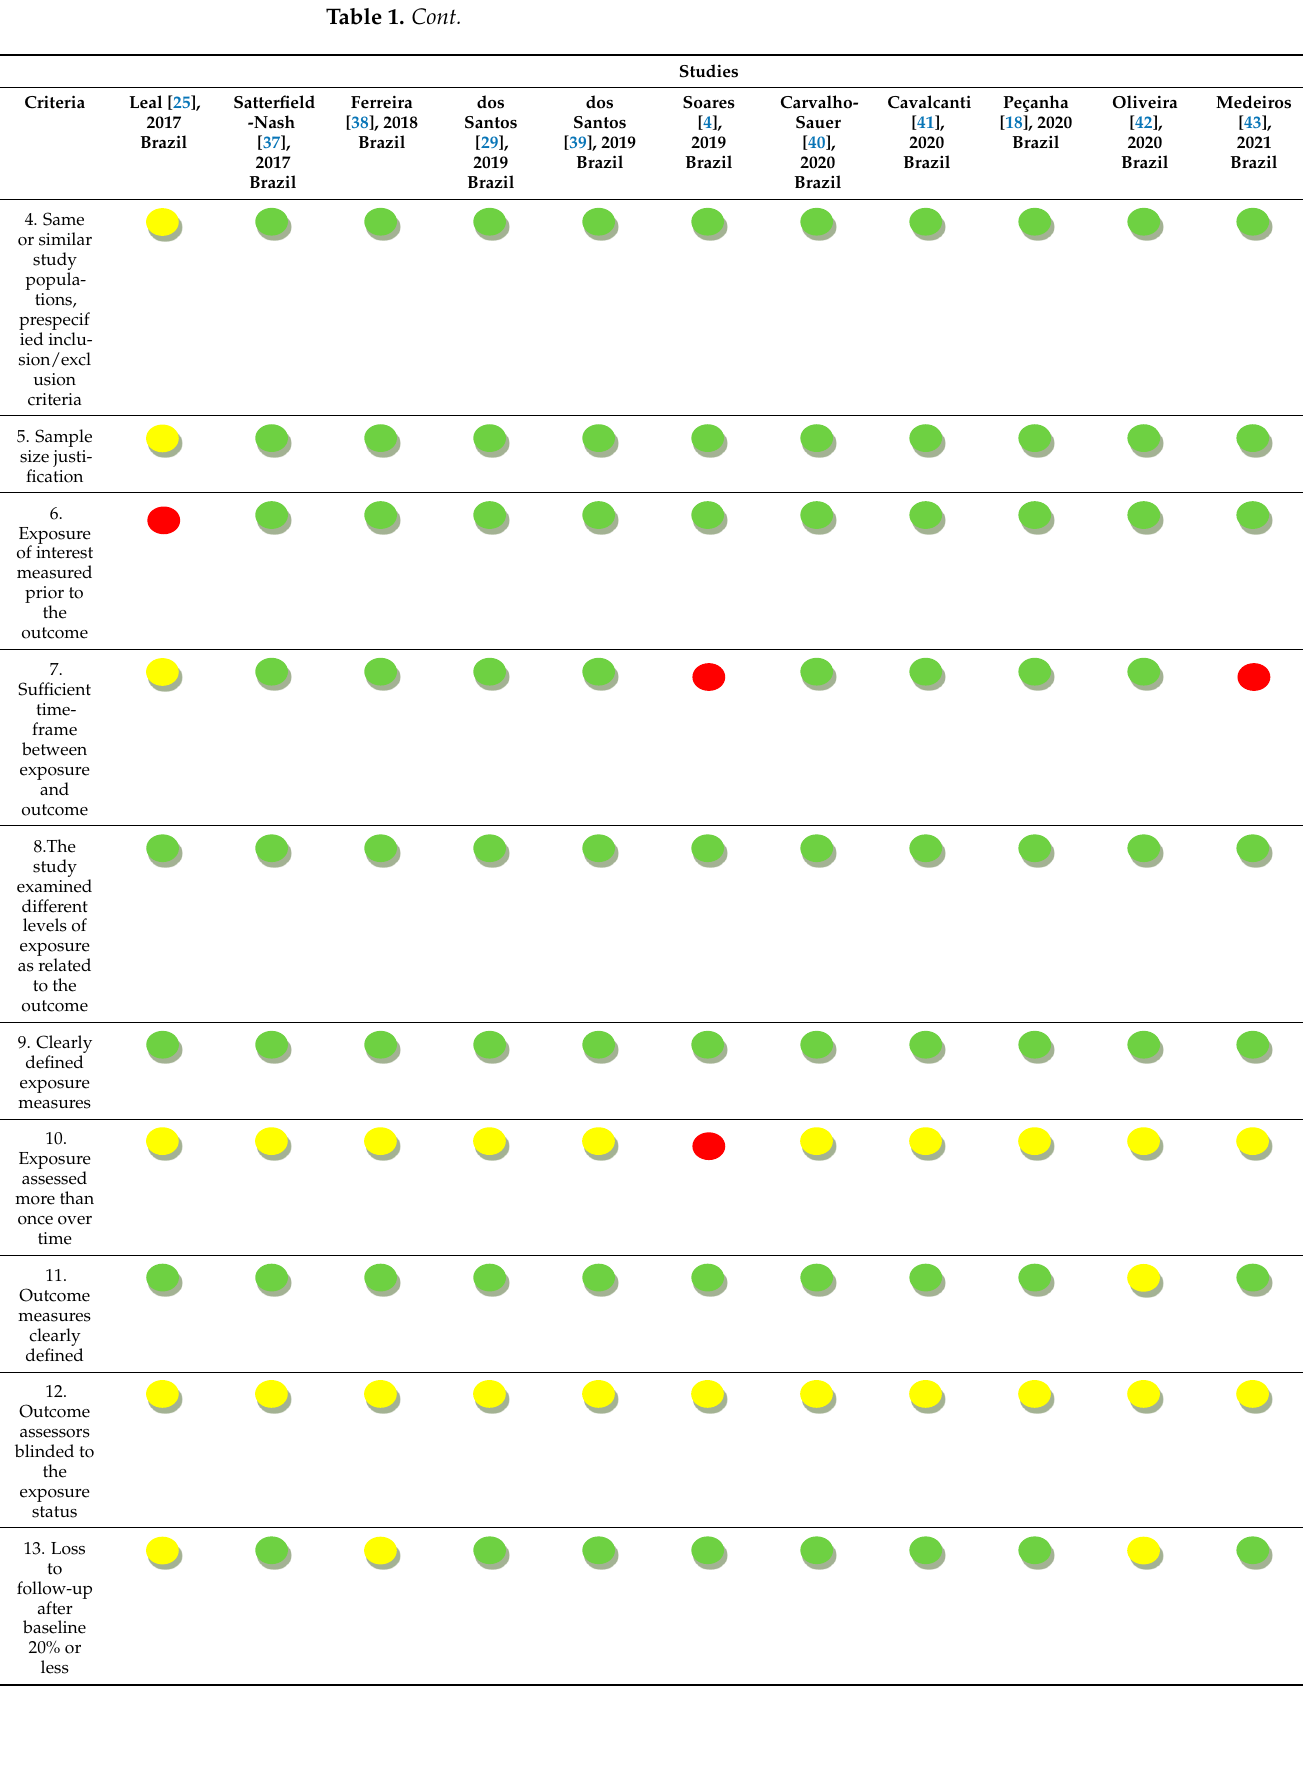
Table 1. Methodological quality and risk of bias of included articles.